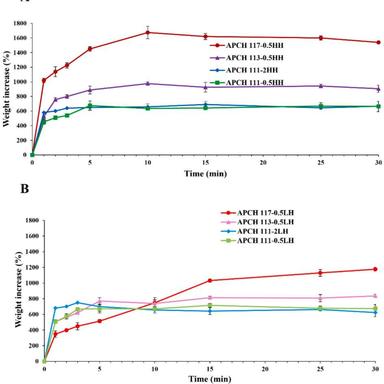
Simulated wound fluid uptake of different APCH formulations. Panel A: APCHs loaded with high molecular weight hyaluronate; Panel B: APCHs loaded with low molecular weight hyaluronate.